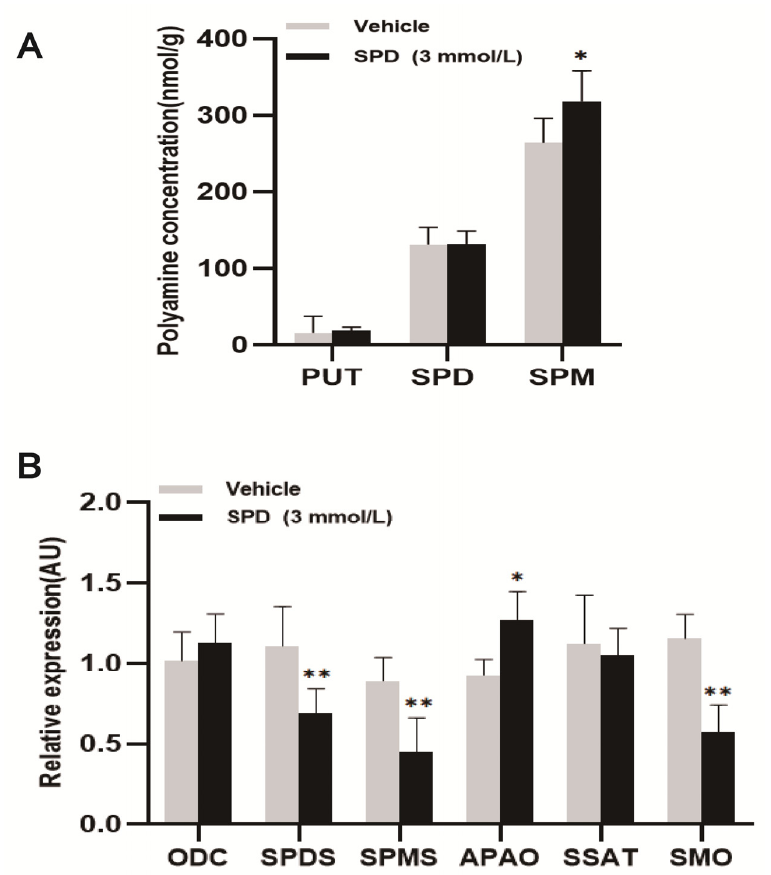
Figure 3. The effects of spermidine on polyamine content and the expression of key metabolic genes in mouse ovaries. ( A ) The effect of spermidine on polyamine content in mouse ovary (PUT: putrescine; SPD: spermidine; SPM: spermine (nmol/g)). ( B ) The effects of spermidine on the expression of key genes of polyamine metabolism in the mouse ovary. The results shown are representative of three independent experiments. * p < 0.05 vs. control. ** p < 0.01 vs. control.